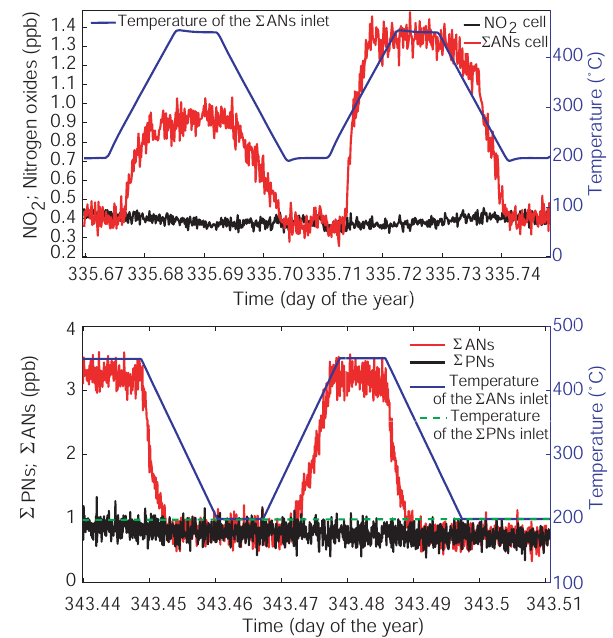
Fig. 6. Upper panel: temperature scan of the P ANs inlet channel when the TD-LIF sampled a mixture of ethyl nitrate and NO 2 . Af- ter the first temperature scan the concentration of ethyl nitrate was doubled. For all the experiments the NO 2 cell sampled air at ambi- ent temperature. Lower panel: temperature scan of the P ANs inlet channel when the TD-LIF sampled a mixture of ethyl nitrate and PAN. For all the experiments the P PNs inlet channel was heated to 200 ◦ C to detect